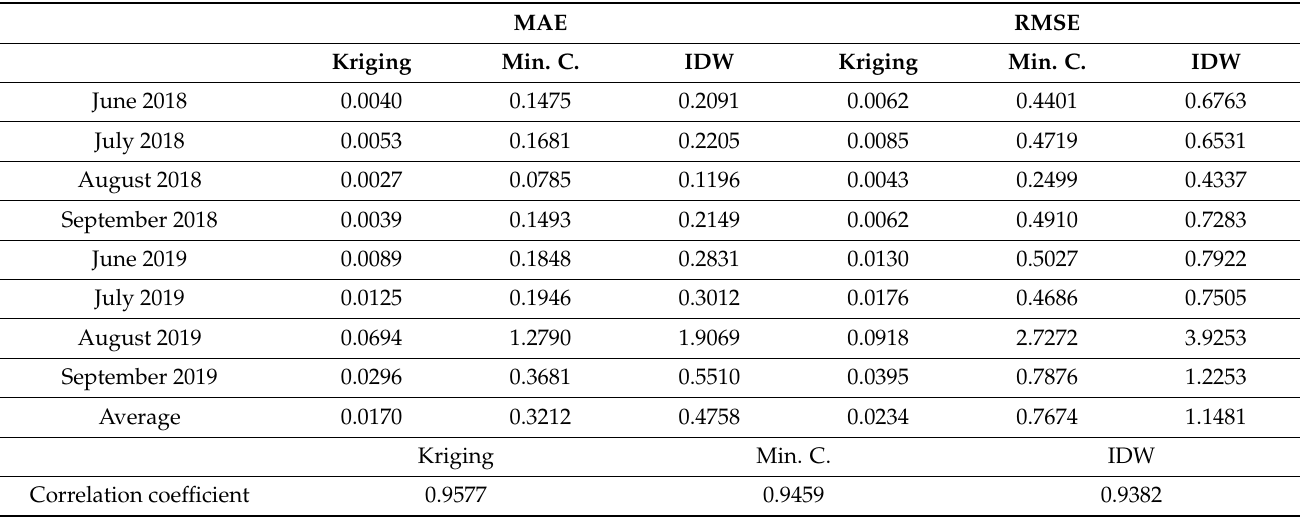
Table 4. Comparison of validation statistical test for spatial interpolation using Kriging, Minimum curvature (Min. C.), and IDW methods.